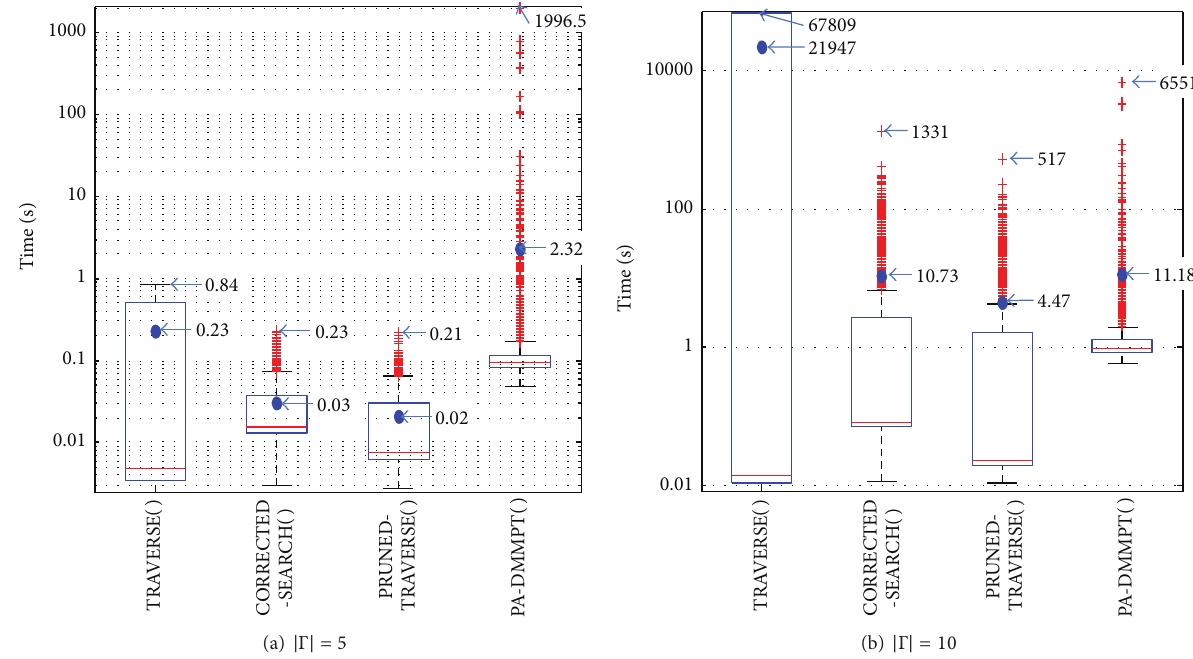
Figure 4: Actual runtimes in seconds when 𝑈 = 0.9